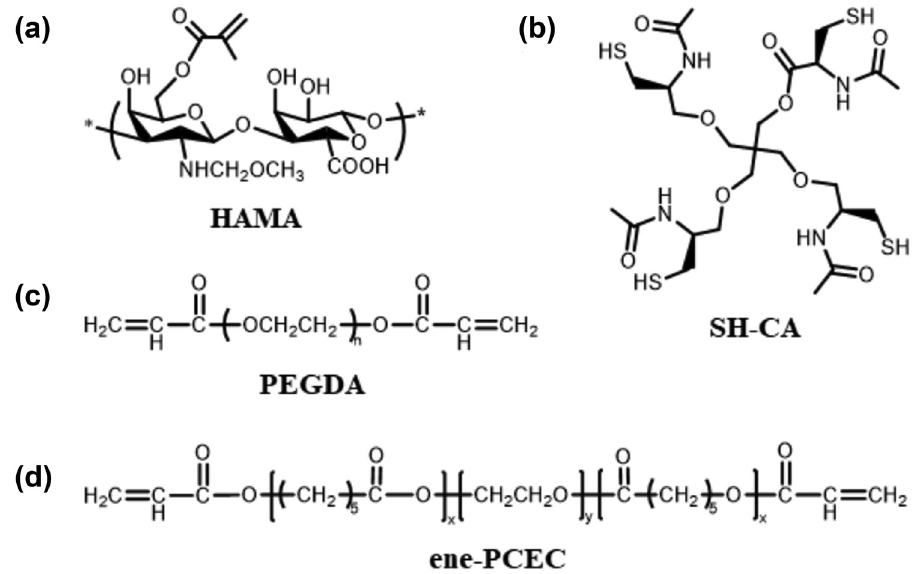
Figure 1: Chemical structures of methacrylated hyaluronic acid ( HAMA ) , multi - thiol crosslinking agent ( SH - CA ) , PEGDA, and acrylated PCL – PEG – PCL triblock copolymer ( ene - PCEC )